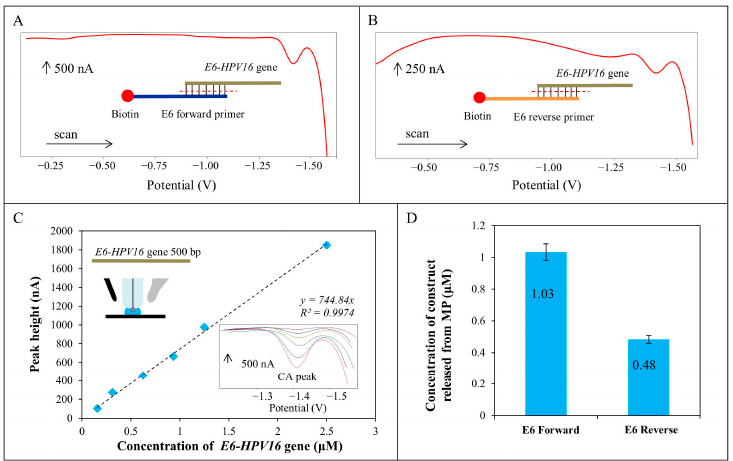
Figure 9. ( A ) Typical SWV voltammograms of E6 forward primer construct released from commercial M-280 MPs; ( B ) compared with E6 reverse primer construct released from commercial M-280 MPs; ( C ) calibration curve of E6-HPV16 gene in concentration range from 0.15 to 2.5 µM, real CA peak voltammograms and scheme of accumulation of sample on surface of working electrode are inserted; and ( D ) concentration of E6-HPV16 gene construct isolated by commercial M-280 MPs by two different primers (E6 forward and E6 reverse). The up arrows show the scale for each voltammograms.